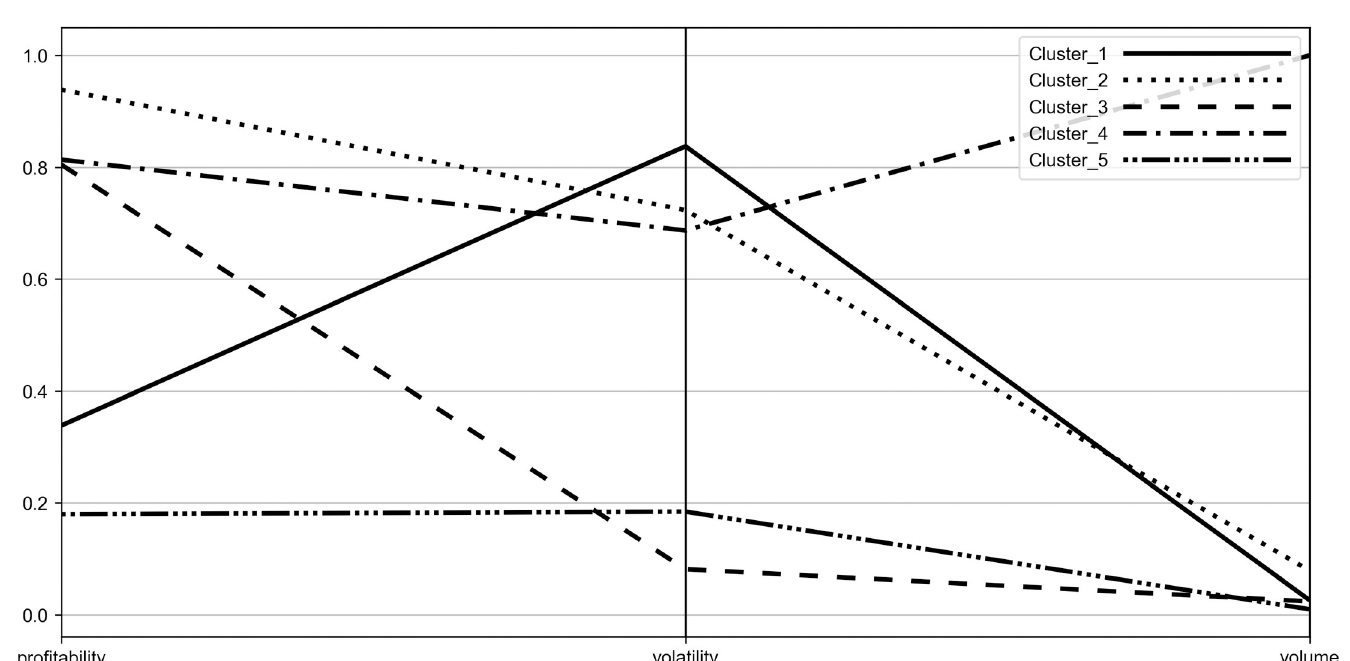
Fig 8. Parallel coordinate plot for centroids–Period_2b.